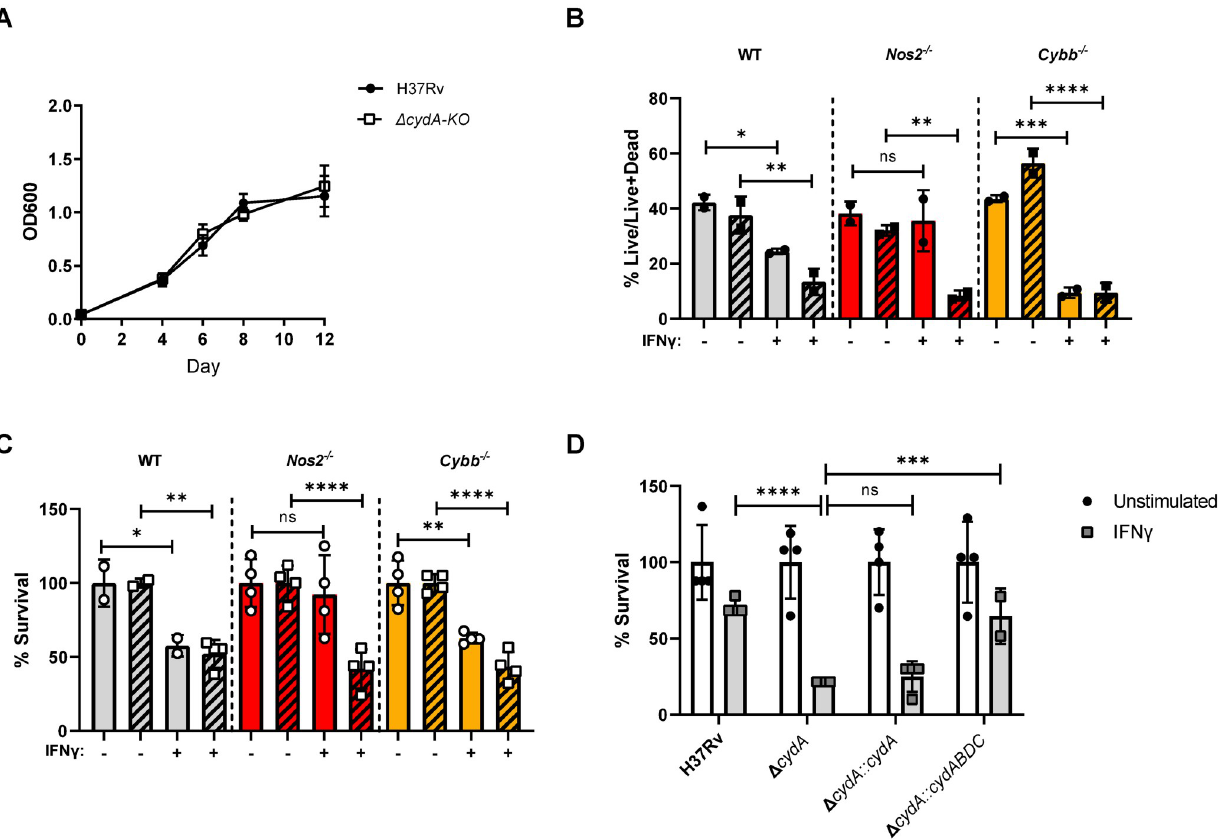
Fig 1. CydA is required to resist IFN γ -mediate immunity independent of NOS2 and Phox. A) Growth of H37Rv and Δ cydA in 7H9 broth over 12 days in 96 well plates. B) C57BL/6J (WT), Nos2 − / − and Cybb − / − BMDMs were left untreated or treated with 25ng/mL of IFN γ for 18 h. Macrophages were infected with H37Rv (solid) or Δ cydA (diagonal bars) live-dead reporter strains (MOI = 5). Y-axis represents the fraction BMDMs with live bacteria (RFP + GFP + ) over total infected BMDMs (GFP + ) determined by flow cytometry at 4 days post-infection. C) IFN γ treated or untreated BMDMs were infected (MOI = 5) with H37Rv (solid) or Δ cydA (diagonal bars). CFU determined 4 days post-infection. Data were normalized using the following formula, [sample value]/[mean of untreated] � 100, error bars reflect the normalized values. Mean of untreated for H37Rv in WT, Nos2 − / − , and Cybb − / − BMDMs: 9.9x10 4 , 1.28x10 5 , and 8.5x10 4 CFU/mL, respectively. Mean of untreated for Δ cydA in WT, Nos2 − / − , and Cybb − / − BMDMs: 4.7x10 4 , 1.0x10 5 , and 7.45x10 4 CFU/mL, respectively. D) IFN γ treated or untreated Nos2 − / − BMDMs infected with the indicated strains (MOI = 5). CFU determined 4 days post- infection. Represented as percent survival relative to untreated, as in panel C. Mean of untreated for H37Rv 4.1x10 4 CFU/mL, Δ cydA 3.7 x10 4 CFU/mL, Δ cydA :: cydA 4.0 x10 4 CFU/mL, and Δ cydA :: cydABDC 3.1 x10 4 CFU/mL. Analysis of B-D was preformed using one-way ANOVA with Sidak post-test to correct for multiple comparisons. � p-value < 0.05, �� p-value < 0.01, ��� p-value < 0.001, ���� p-value < 0.0001. Data depict single experiments that are representative of at least 2 independent